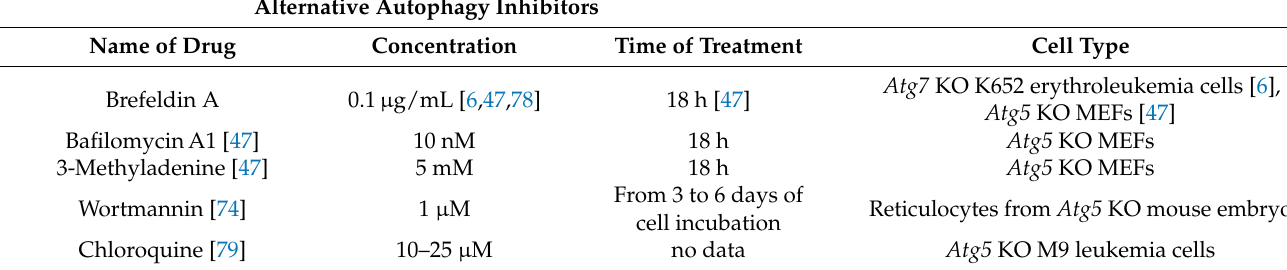
Table 2. Alternative autophagy